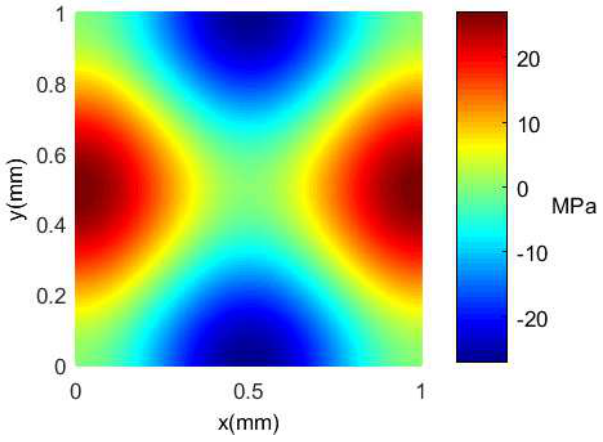
Figure 11. The MATLAB nephogram of σ x − σ y